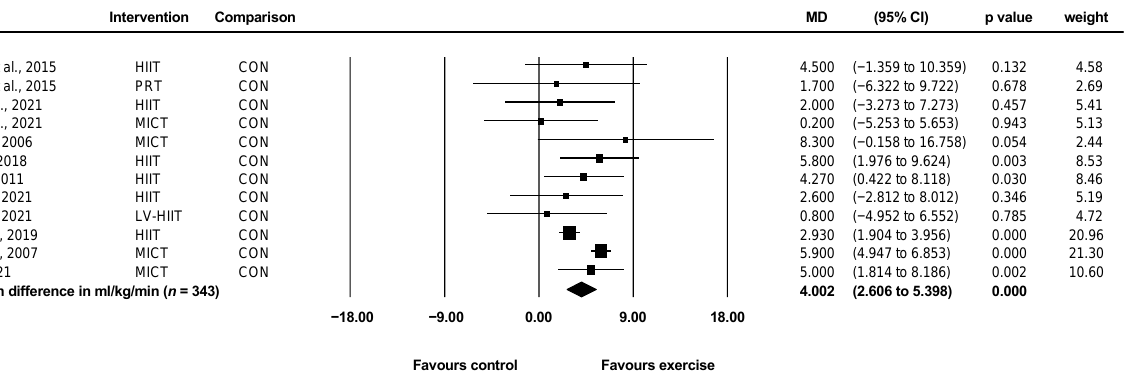
Figure 3. Effect of exercise vs. control for change in cardiorespiratory fitness. CI: confidence interval, CRF: cardiorespiratory fitness, HIIT: high-intensity interval training, LV-HIIT: low-volume high- intensity interval training, MD: mean difference, MICT: moderate-intensity continuous training, PRT : progressive resistance training.